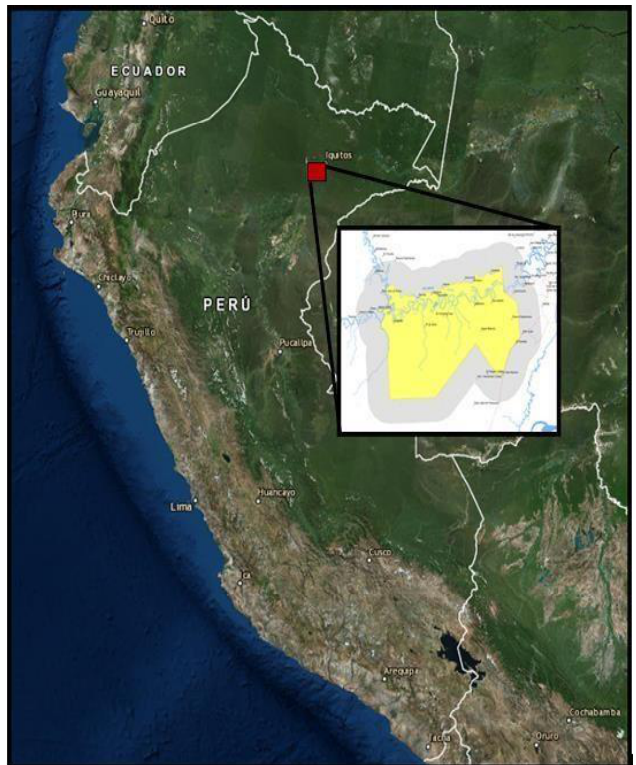
Figure 1: Allpahuayo Mishana National Reserve Map